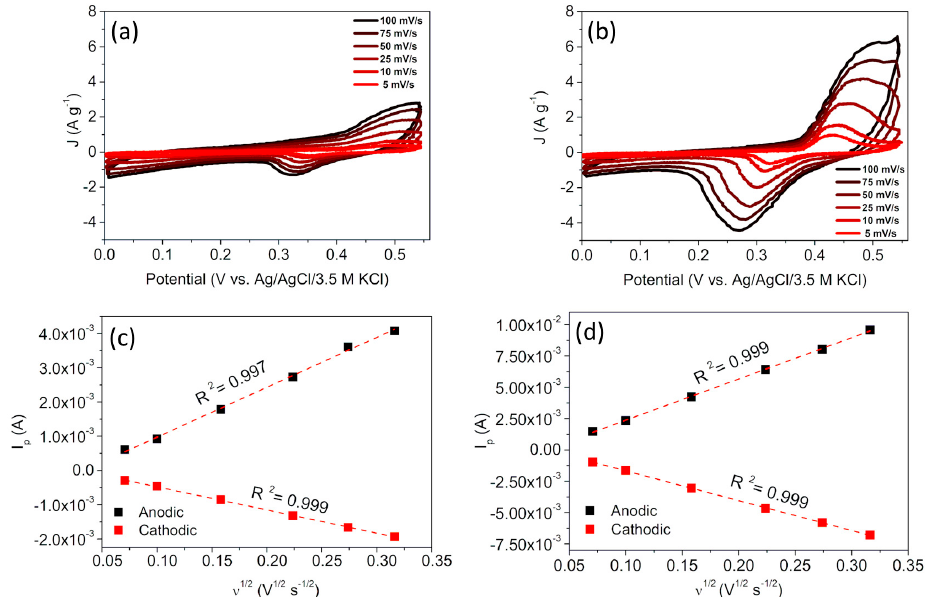
Figure 4. Cyclic voltammograms obtained at different scan rates (5–100 mV s − 1 ) for 1 ( a ) and 2 ( b ). Anodic and cathodic peak current dependence on the square root of the scan rate for 1 ( c ) and 2 ( d ). Electrolyte: 1.0 M KOH.